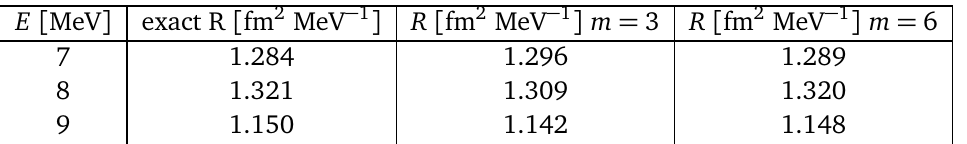
Table 1: The exact response R ( E ) and those obtained via inverting the LIT for basis = E m and m = 3 and m = sets with f thr